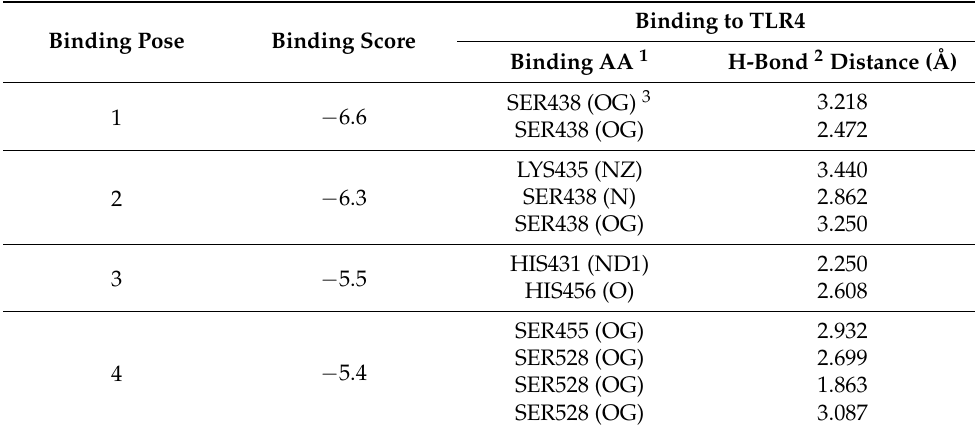
Table 2. The docking of fisetin to TLR4-MD2 (PDB: